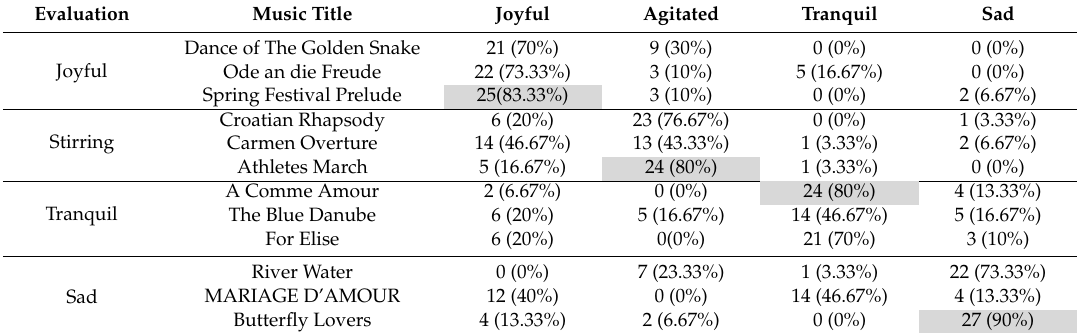
Table 3. Typical Musical Emotion Evaluation